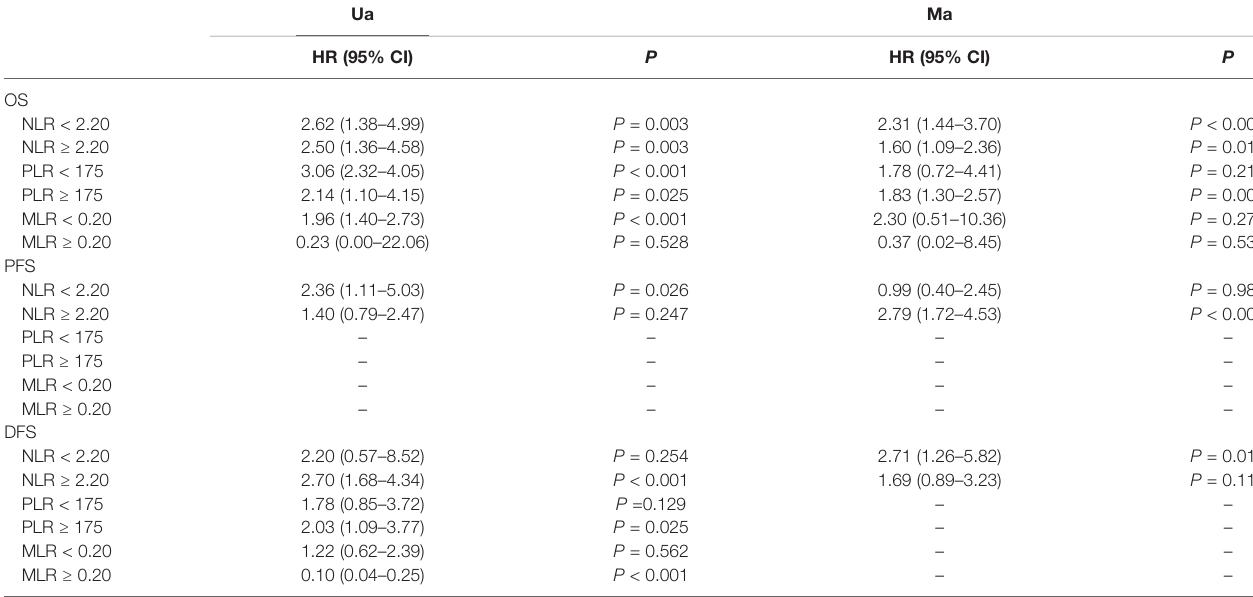
TABLE 9 | Survival outcomes of patients strati fi ed according to neutrophil – lymphocyte ratio (NLR), platelet – lymphocyte ratio (PLR) , and monocyte – lymphocyte ratio (MLR) cutoffs are summarized